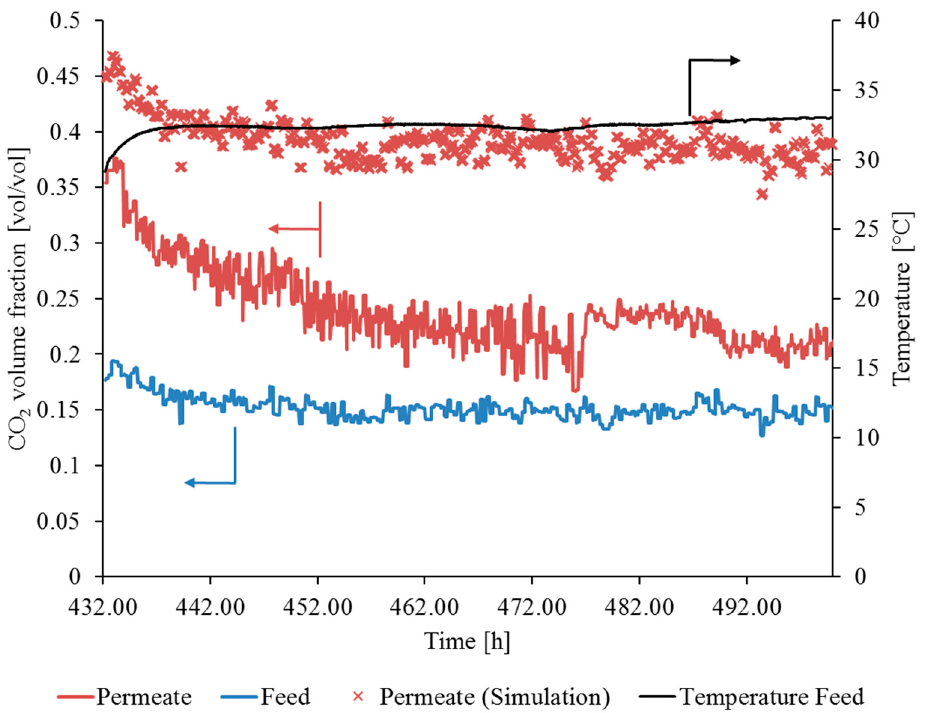
Figure 15. SILM failure during flue gas operation: y (cid:2890),(cid:2887)(cid:2899) . period, V N,F ~5.5 m 3 (STP)/h, p (cid:2926) ~125 mbar.